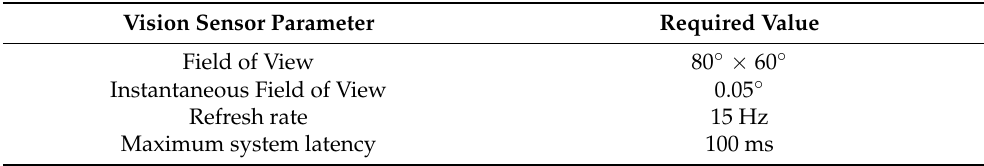
Table 1. Summary of the estimated requirements to implement vision sensors in UAM approach and landing scenarios.